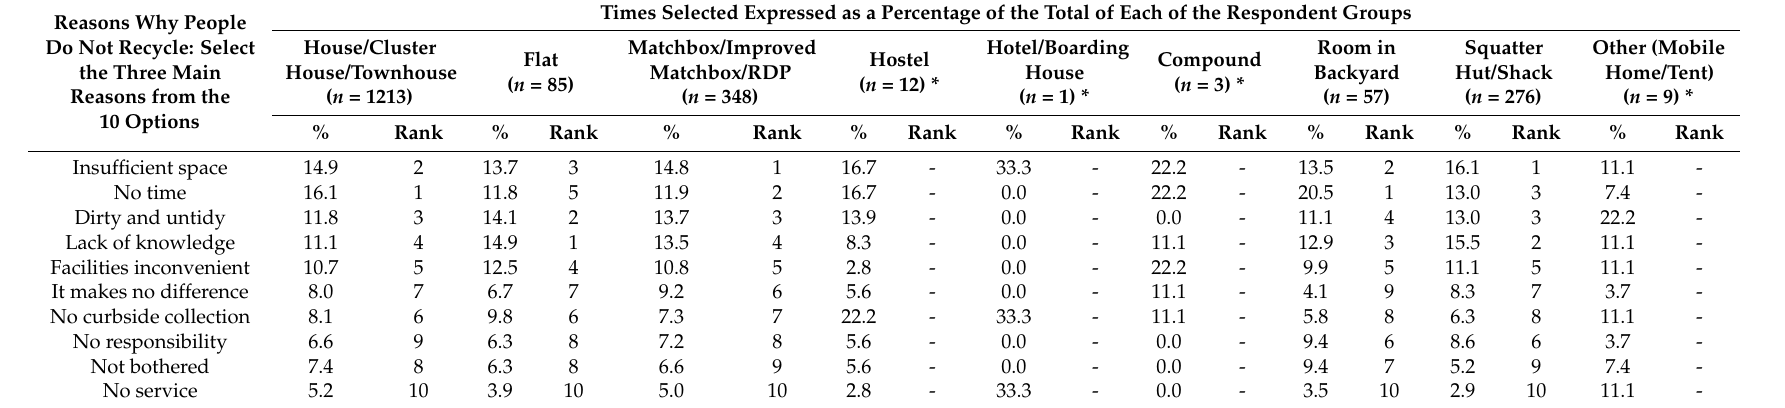
Table A3. Reasons why people do not recycle as enumerated per type of dwelling ( n = 2004).